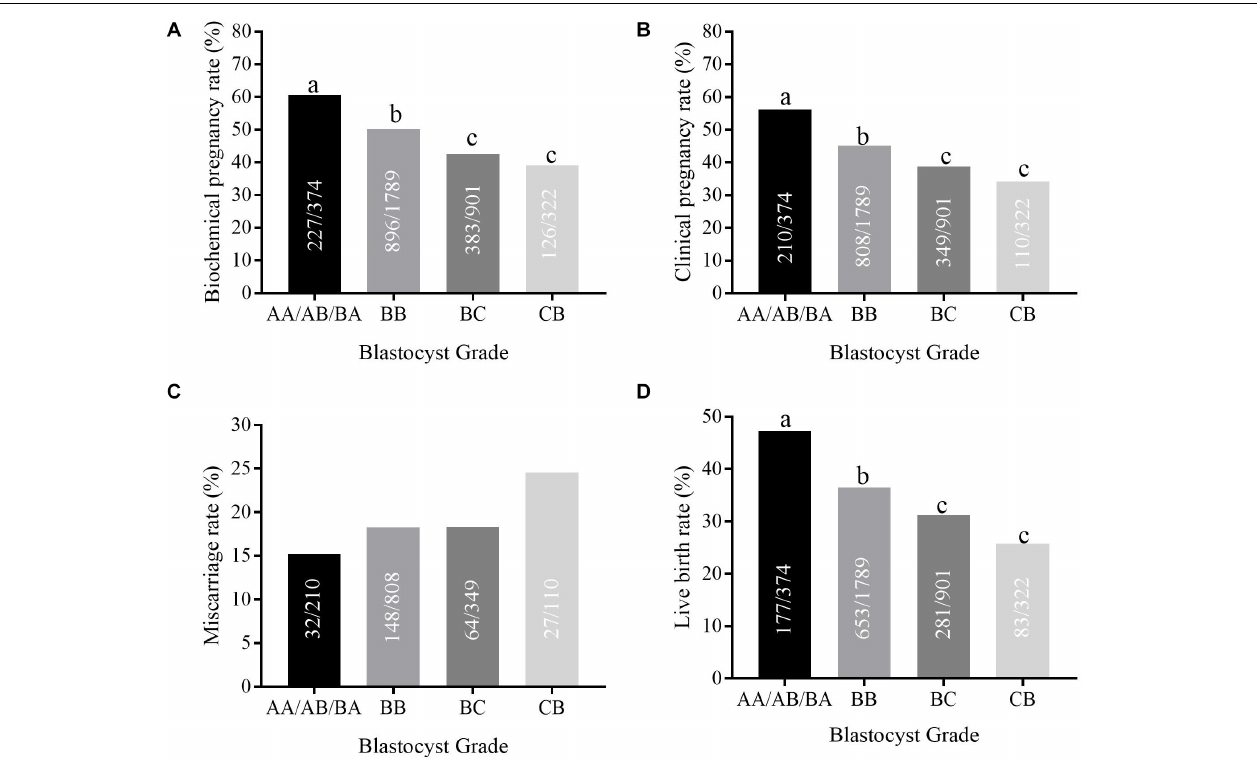
FIGURE 1 | The clinical pregnancy outcomes in different blastocyst grade groups. (A–D) shows the biochemical pregnancy rate, clinical pregnancy rate, implantation rate, and live birth rate in different blastocyst grade groups (AA/AB/BA, BB, BC, and CB group). Different letters represent significant difference (P < 0.05). TABLE 1 | The constitution proportions of embryos with different cleavage-stage quality and development speed in four blastocyst grade groups. Group 1 AA/AB/BA Group 2 BB ( n = 1789) Group 3 BC ( n = 901) Group 4 CB ( n = ( n = 374)